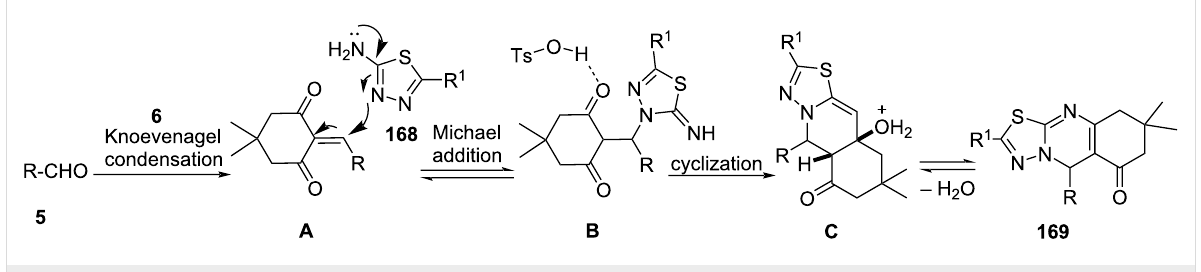
Scheme 70: Proposed mechanism for the thiazoloquinazolinone synthesis.